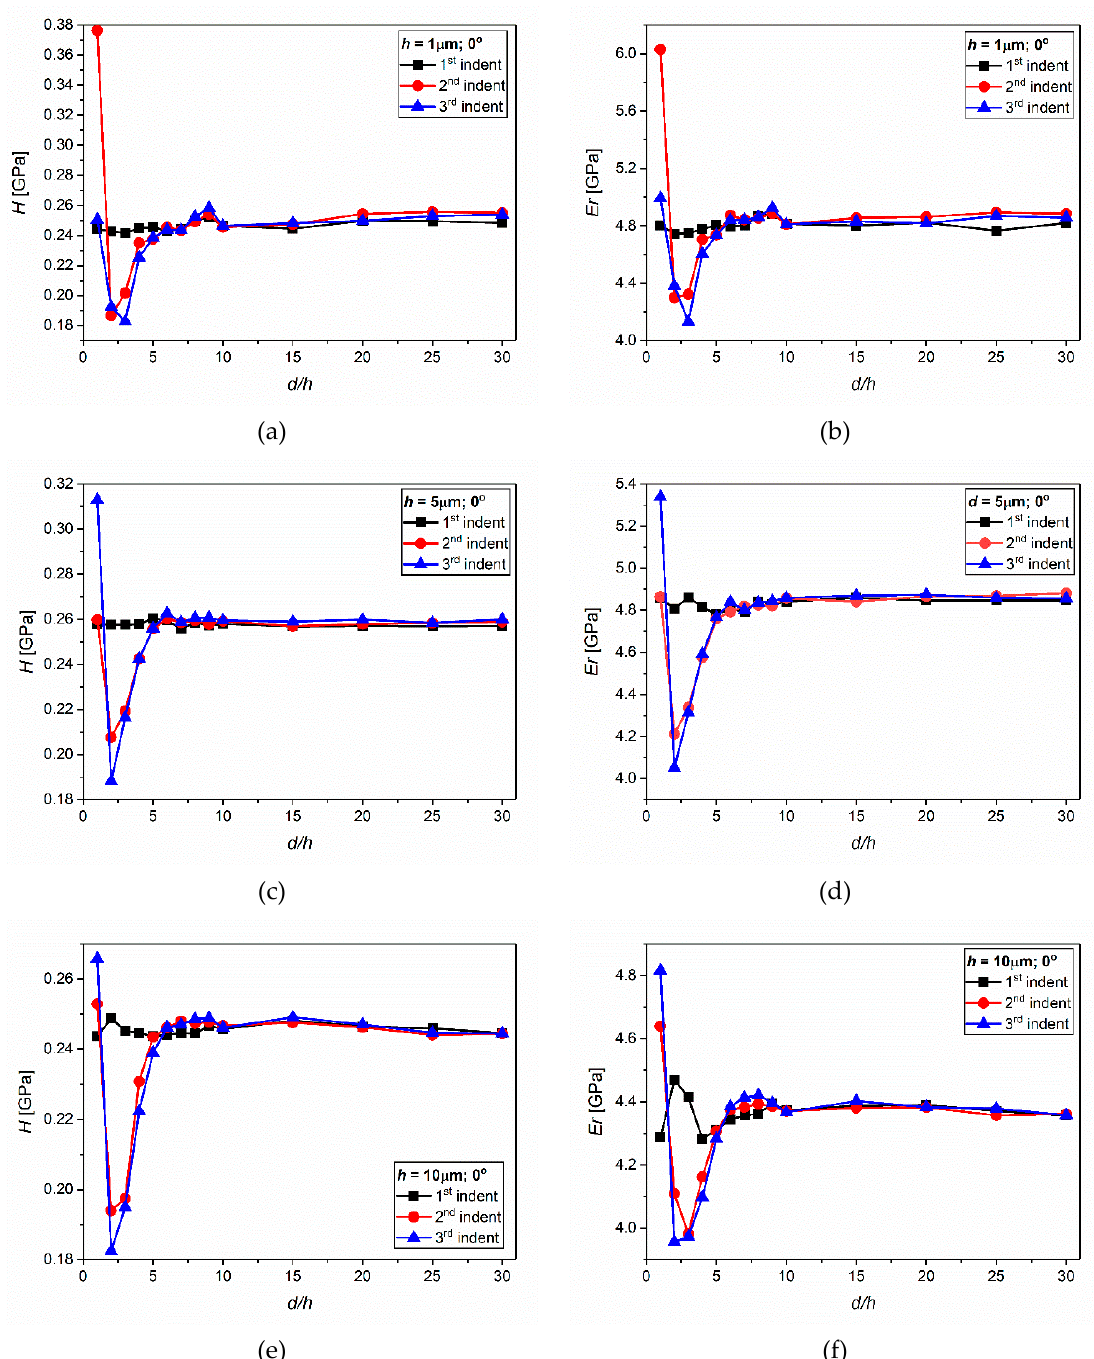
Figure 4. Hardness ( H ) and reduced modulus ( Er ) for each indent measured in a single row (orientation 0°) at different indentation depth and spacing. ( a , b ) h = 1 µm; ( c , d ) h = 5 µm; ( e , f ) h = 10 µm.